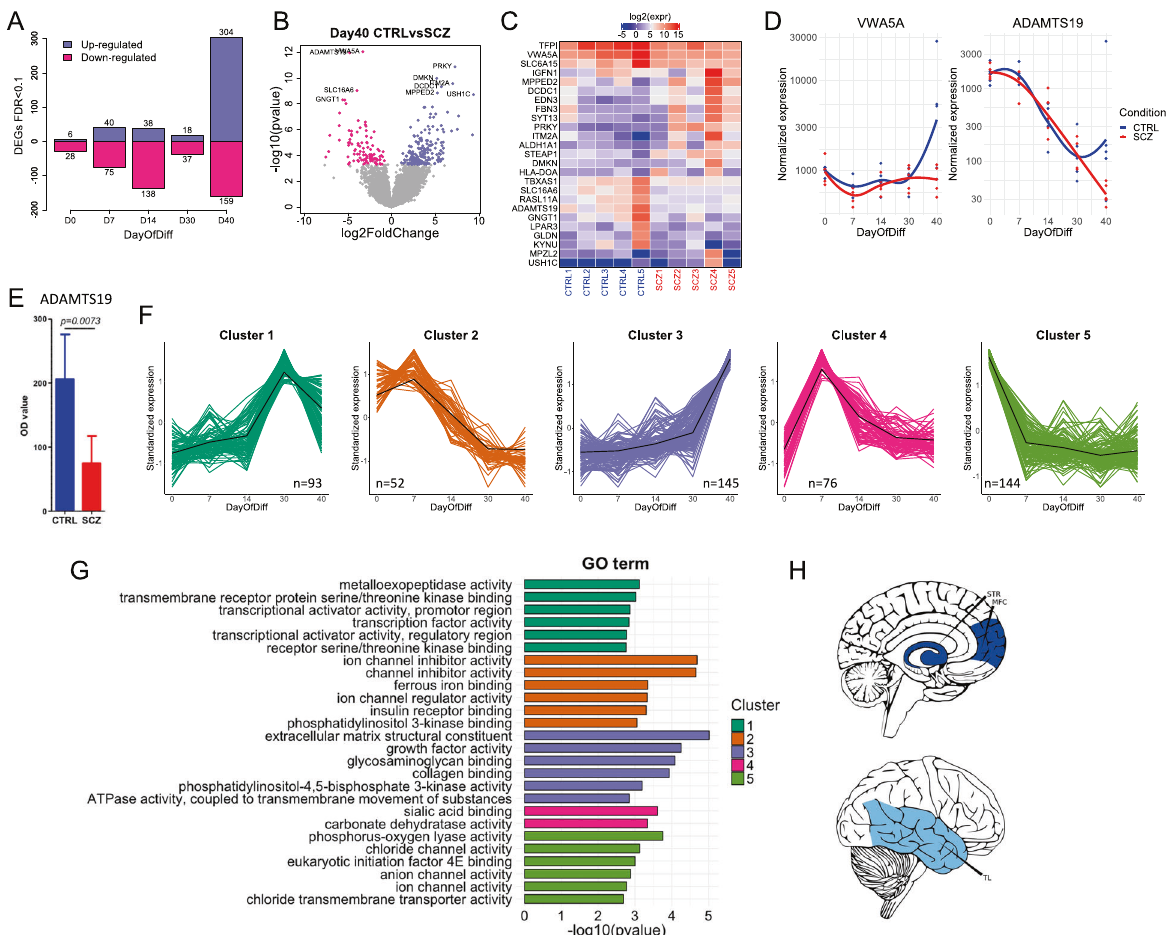
Fig. 5 SCZ-associated genes and gene clusters are involved in ion channel and matrix metalloproteinase activity, and are enriched in speci fi c brain regions. A Barplot of signi fi cant SCZ-related genes up and downregulated at each stage of differentiation. B Volcano plot showing the logarithmic fold change and p -value of each gene with differential expression in day 40 SCZ astrocytes compared to CTRLs. C Heatmap of top 25 SCZ-associated genes at day 40 of differentiation. D Normalized expression trajectory of the top two signi fi cant day 40 SCZ-associated genes. E Assessment of protein expression of ADAMTS19 in day 40 astrocyte cultures using ELISA. Data is based on triplicate measurements in cell cultures from all 10 donors, 5 CTRL (blue) and 5 SCZ (red). Relative ADAMTS19 protein expression is presented as mean OD value ± SEM. F Soft clustering of SCZ-associated DE genes resulted in 5 distinct clusters with shared expression trajectories. The number of genes in each cluster is shown. Only genes with cluster membership >0.5 were used for cluster generation. The black lines (centroids) represent mean standardized expression across SCZ samples. G Top signi fi cant cluster annotations (molecular functions) and corresponding − log10( p -value) for each gene cluster. GO: Gene Ontology. H Enrichment of SCZ-associated genes in speci fi c brain regions in the developing human brain. Dark blue indicates brain regions with adjusted enrichment p -value <0.05. Light blue indicates brain regions with adjusted enrichment p -value = 0.102. STR striatum, MFC medial prefrontal cortex, TL temporal gene set expression enrichment test. The SCZ-associated DE genes were signi fi cantly enriched in the medial prefrontal cortex (MFC) and striatum, and displayed a weaker enrichment in the temporal lobe suggesting that astrocyte differentiation in these brain areas is affected in the developing brains of SCZ patients. The complex nature of neuropsychiatric diseases entails that their molecular substrates are subject to tight spatial regulation and possess speci fi c expression patterns across the brain parenchyma, so that they disrupt speci fi c cognitive functions but preserve the basic functions and most of the higher-order processes of the brain. Ion channel proteins in the human brain are regulated by diverse factors ranging from a multitude of discrete isoforms and receptor subunit combinations within ion channel families and subclasses, each of which displays a speci fi c distribution that is developmentally and spatiotemporally controlled in the brain [56 – 58]. Our results demonstrating that associated markers have been shown in the prefrontal [67, 68] and developing iPSC astrocytes in SCZ abnormally downregulate ion subcortical regions [69] of the brain in SCZ. Moreover, astrocytic loss/ channel-activity-related genes are in agreement with a previous